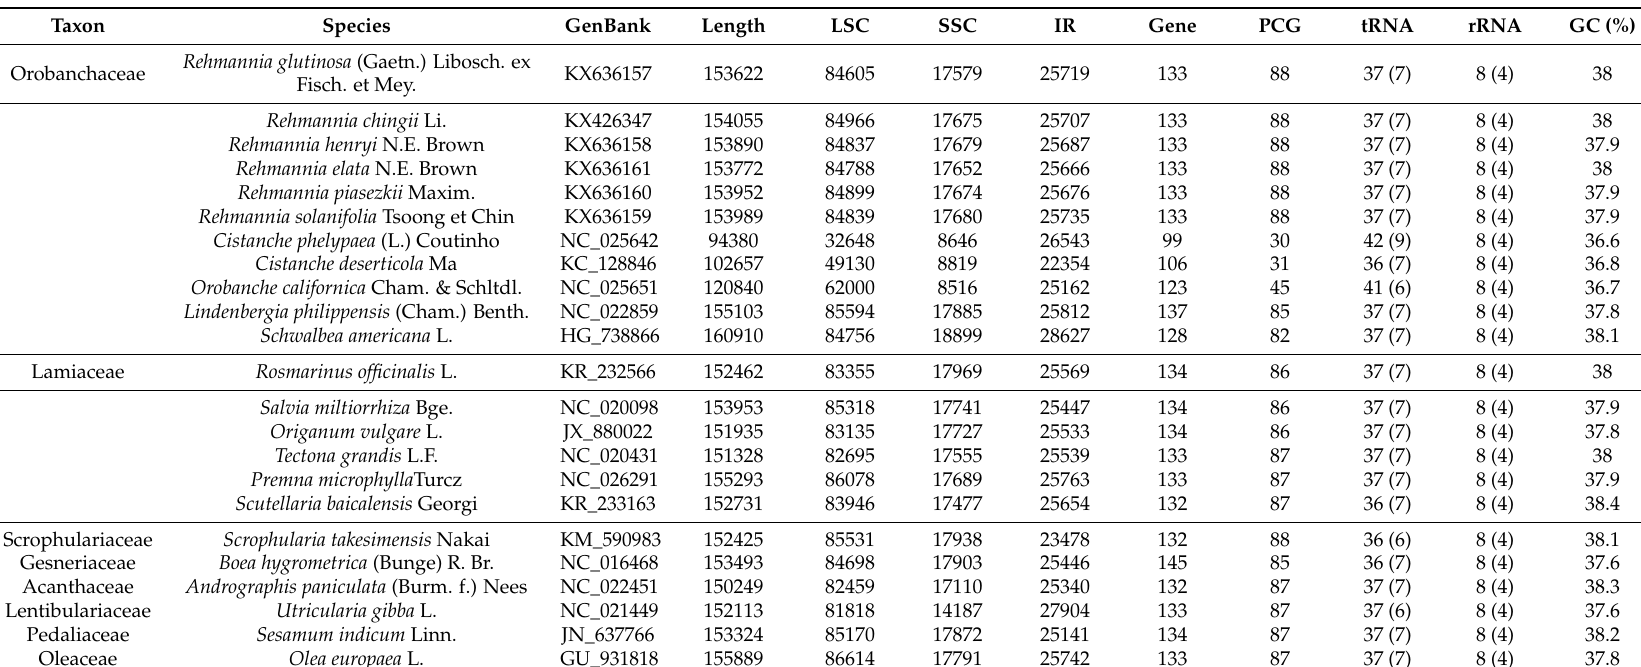
Table 2. Summary of chloroplast (cp) genomic data of all Lamiales taxa used in the study. The numbers in parenthesis indicate the genes duplicated in the inverted repeat (IR)